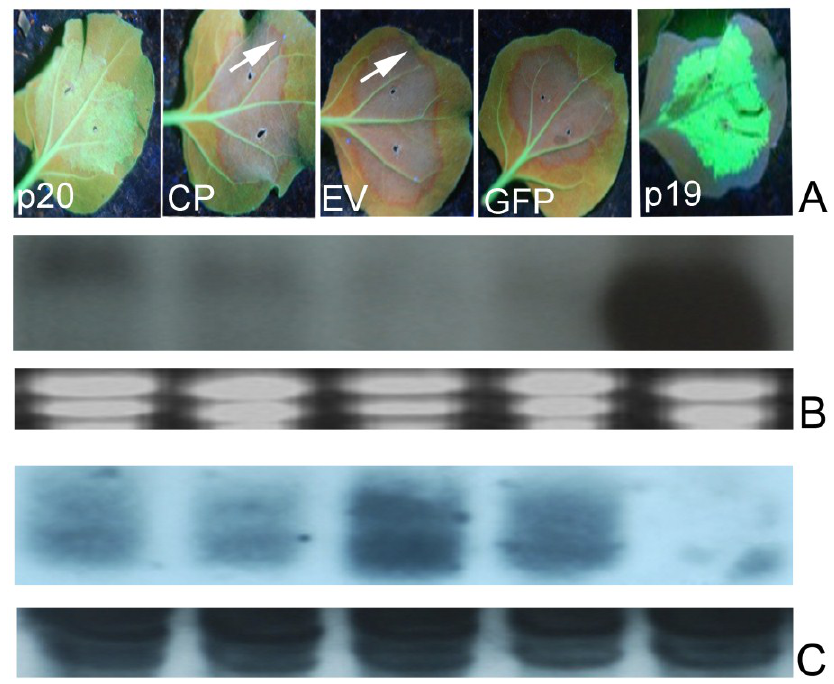
Figure 3. Effect of PMWaVs ORFs on the short distance spread (10–15 cells) of the GFP silencing signal in N. benthamiana 16C plants. ( A ) Leaves co-infiltrated with A. tumefaciens cultures harboring constructs pBI-35S-sGFP plus PMWaV-2 p20,